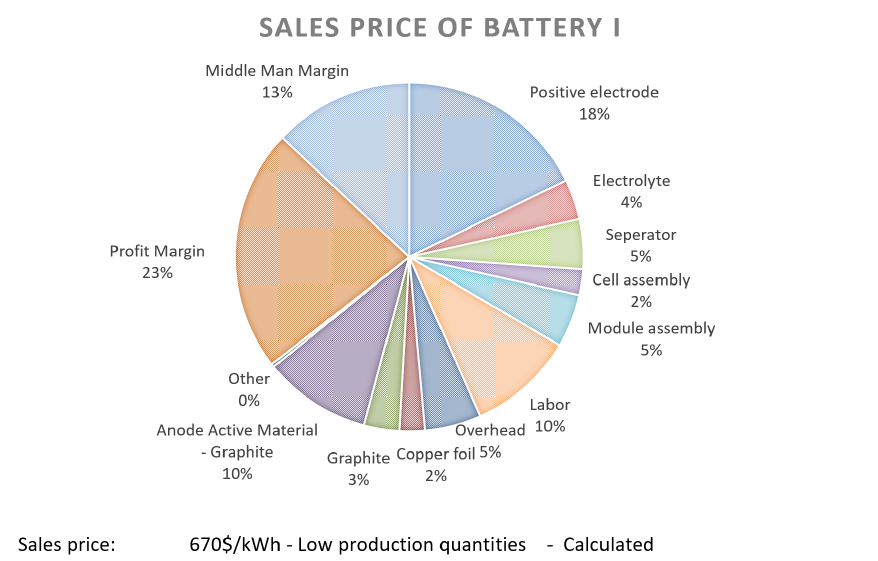
Figure 7. Sales price of battery I.